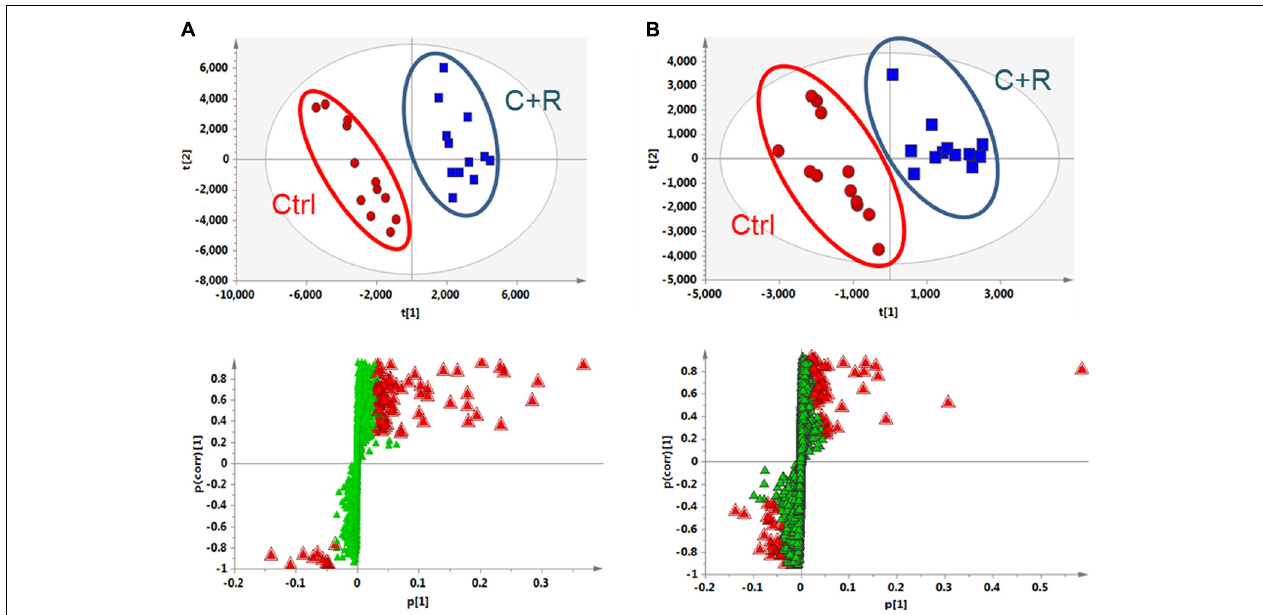
FIGURE 5 | Partial least squares discriminant analysis (PLS-DA) score and S -plot of saline control (Ctrl) and cinnabar and reaglar co-administration (C+R) groups based on the serum metabolic profiles for (A) positive ( R 2 X = 0.771, R 2 Y = 0.989, and Q 2 = 0.932) and (B) negative ( R 2 X = 0.507, R 2 Y = 0.944, and Q 2 = 0.854) ion mode.